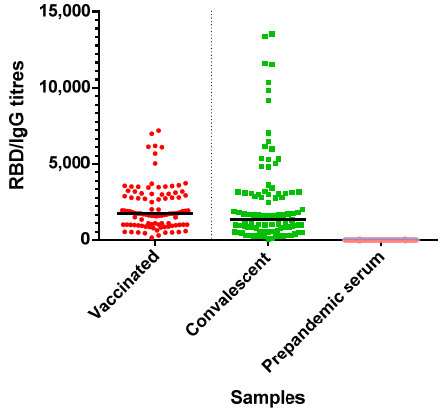
Figure 7. Anti-SARS-CoV-2 RBD IgG antibody titres in 100 Sinopharm-vaccinated recipients (vaccinated), 100 COVID-19-recovered individuals (convalescent) and 96 seronegative subjects (prepandemic serum). The horizontal black line corresponds to the median.